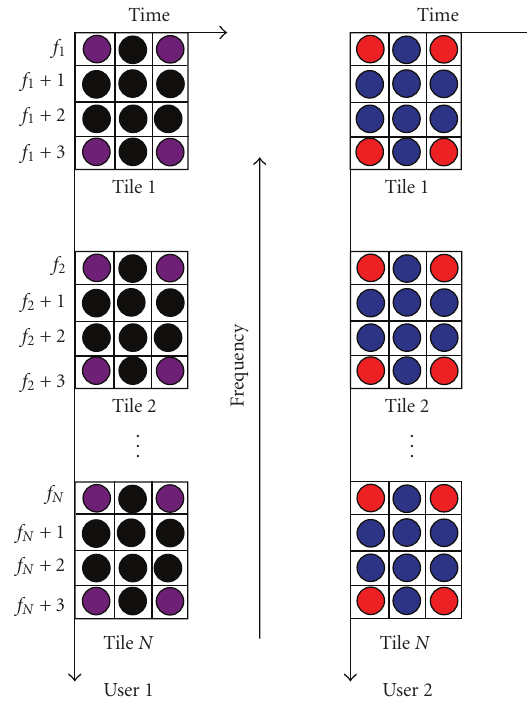
Figure 7: Performance of transmit antenna selection for TDD- based MMSE-BAF system with 4 antennas at the base-station. User- 1 employs QPSK modulation whereas user-2 employs 16-QAM modulation. An uncoded system is considered with realistic channel estimation over block fading channels with 20 pilot and 100 data symbols per fading block.